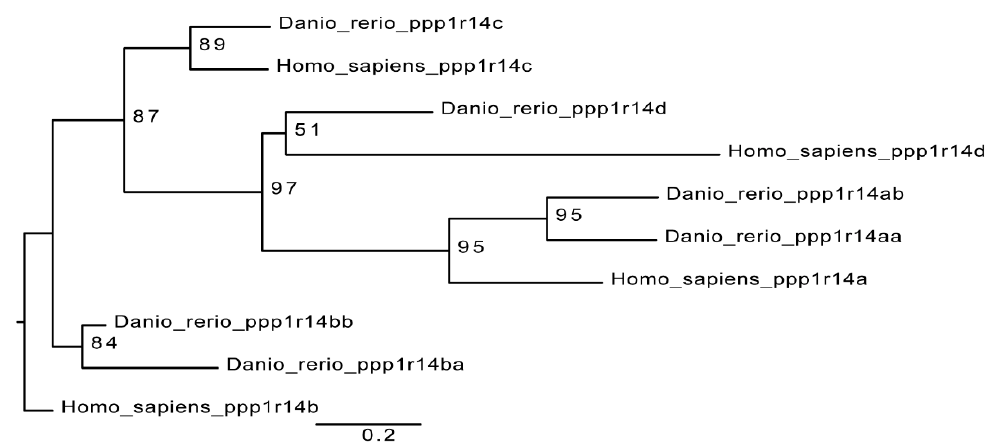
Figure 1. Cpi-17 gene family in zebrafish. The Cpi-17 family in humans consists of ppp1r14a , ppp1r14b , ppp1r14c , and ppp1r14d . The Cpi-17 family in zebrafish consists of two paralogs of both ppp1r14a and ppp1r14b , and a single copy of ppp1r14c and ppp1r14d . Ppp1r14c and ppp1r14d were not expressed in zebrafish early embryonic development.